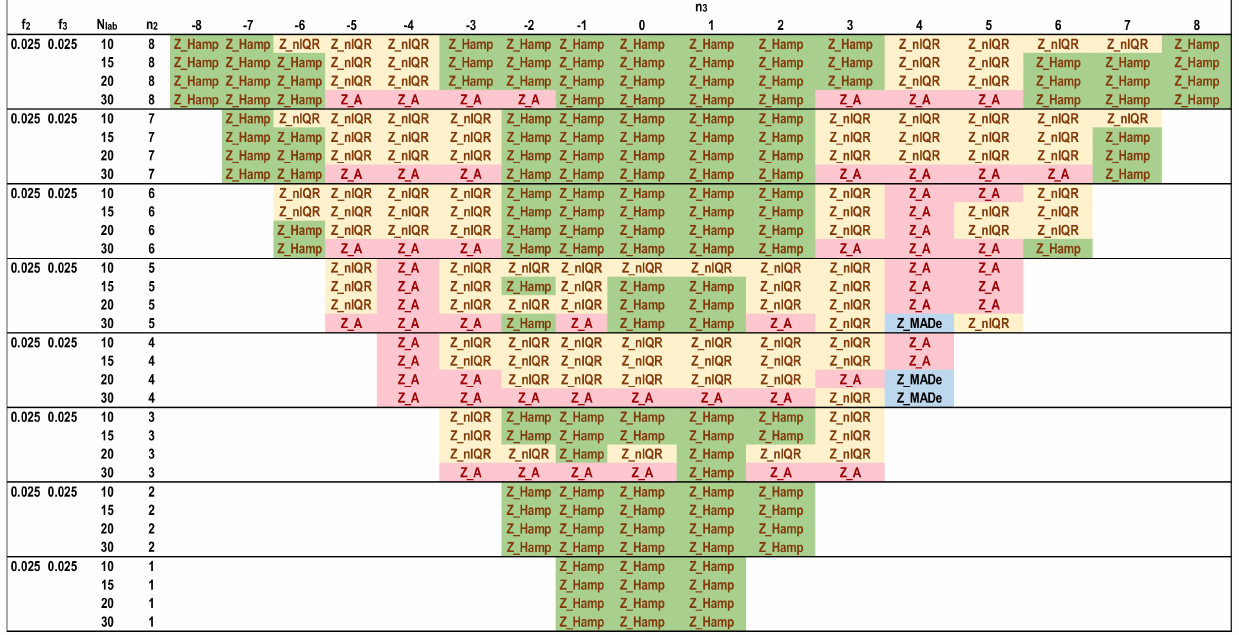
Figure 12. Optimal robust estimators of Zu% for trimodal distributions, f 2 = 0.025 and f 3 = 0.025.